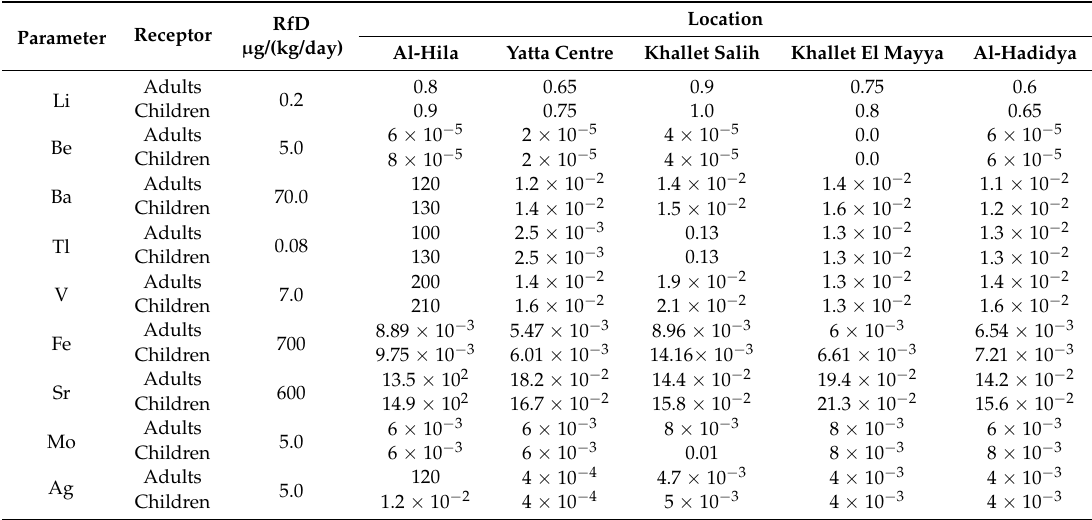
RfD: Values for the rest of the metals were not